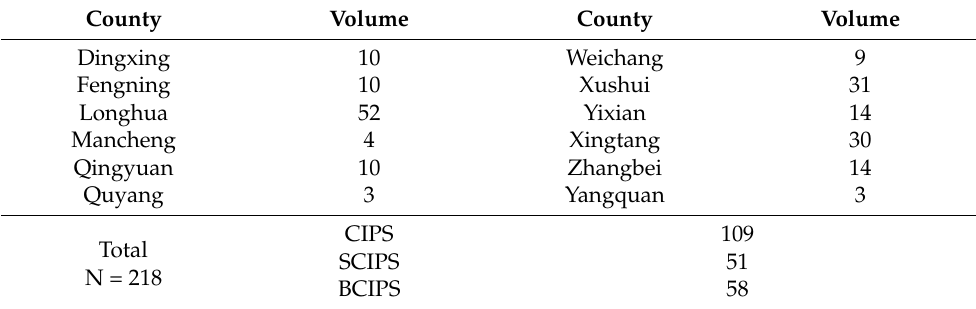
Table A1. The Sample Volume from the Surveyed Counties.